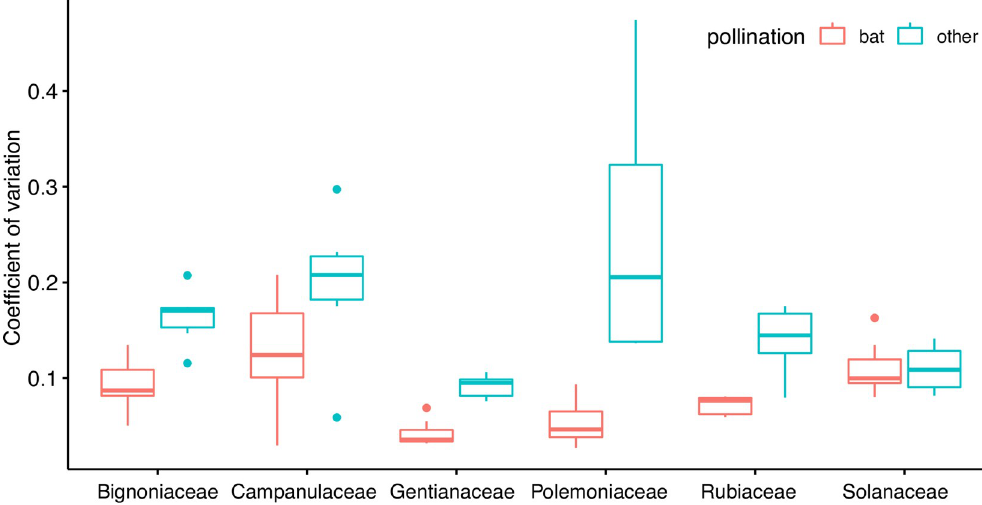
Fig 3. Coefficients of variation for the different morphological flower features for twelve plant species from six different families. Orange: bat-pollinated species. Petrol: bird-or insect-pollinated species. For each species, the coefficients of variation of the length of the corolla, the length of the calyx, and the inner as well as outer diameter of the flowers opening (in the horizontal and vertical plane) was calculated.